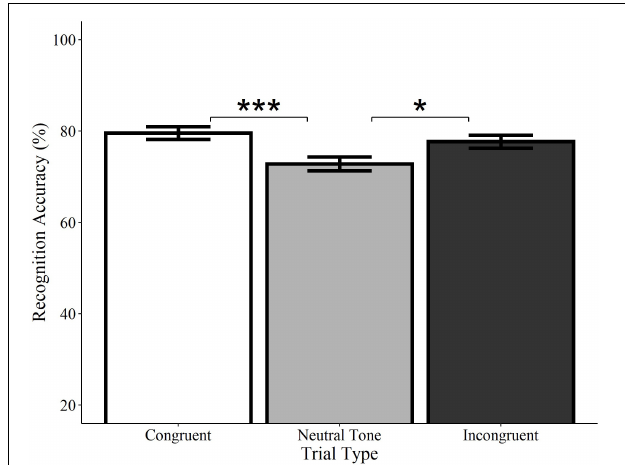
FIGURE 6 | Effect of trial type on recognition accuracy for environmental sounds. Visual objects initially paired with congruent (white) or incongruent (black) environmental sounds were recognized with significantly greater accuracy than those paired with neutral sounds (gray). Congruent and incongruent trials did not significantly differ from each other. Error bars represent standard error. * p < 0.05, *** p < 0.001.